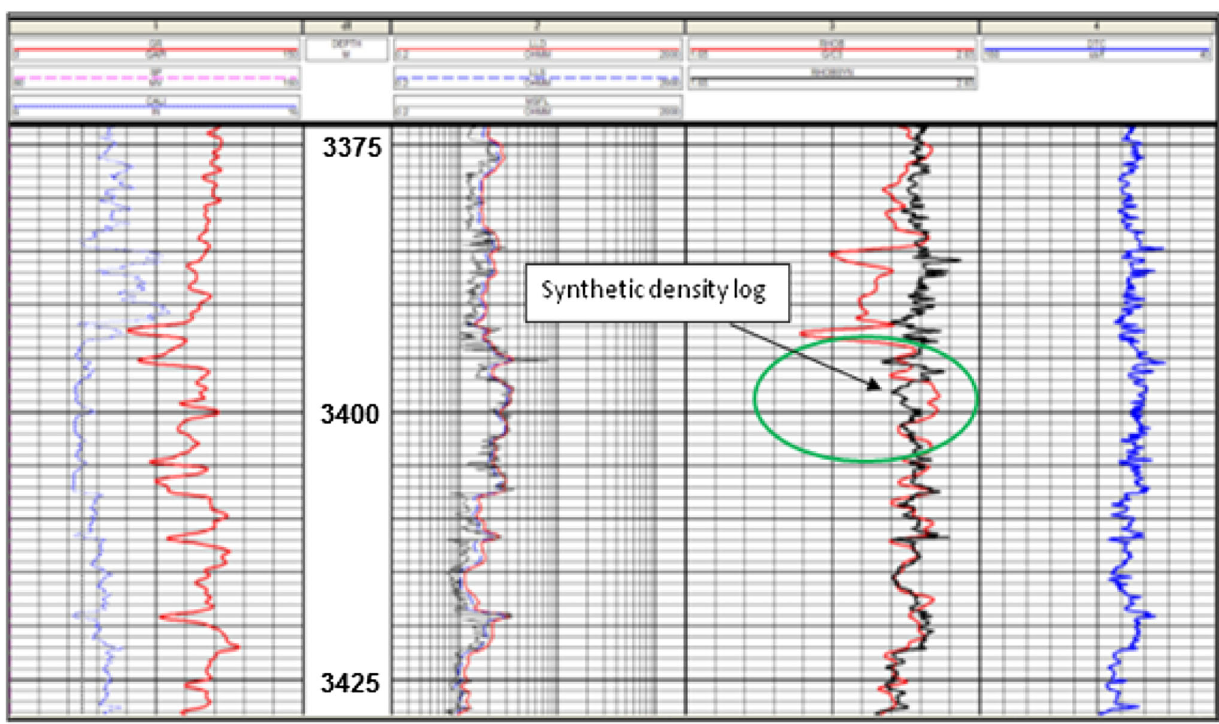
Fig. 5 Well A-synthesized density curve ( black ) on top of measured density curve